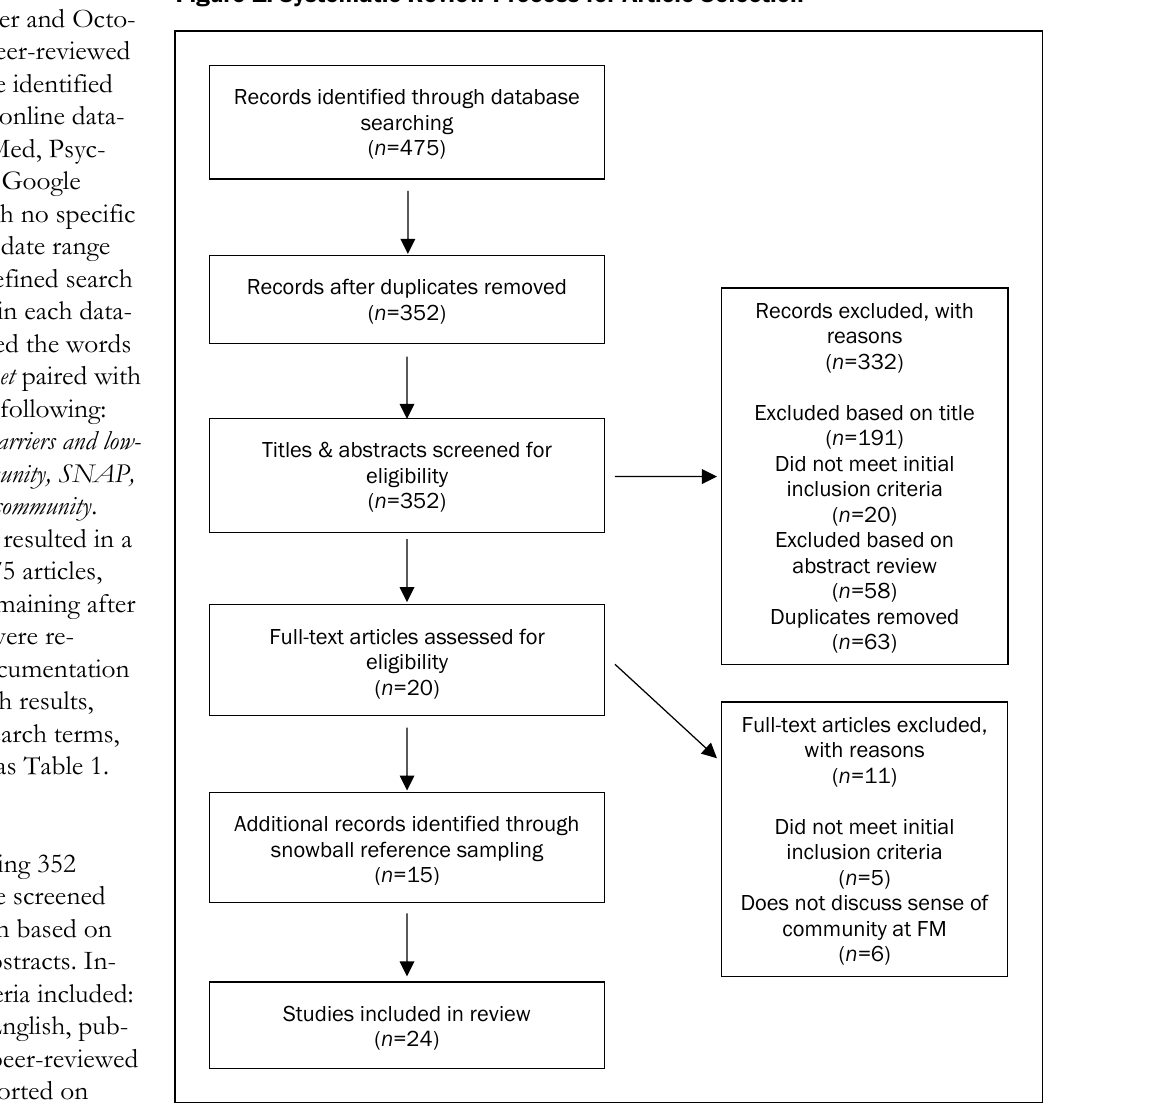
Figure 1. Systematic Review Process for Article